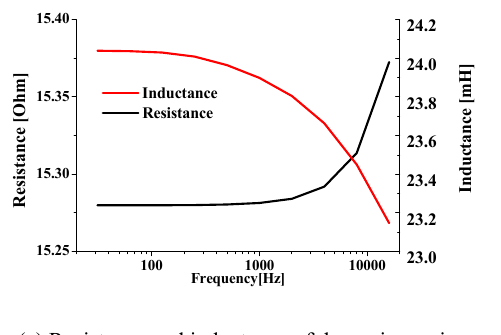
Figure 4. Calculated resistance and inductance